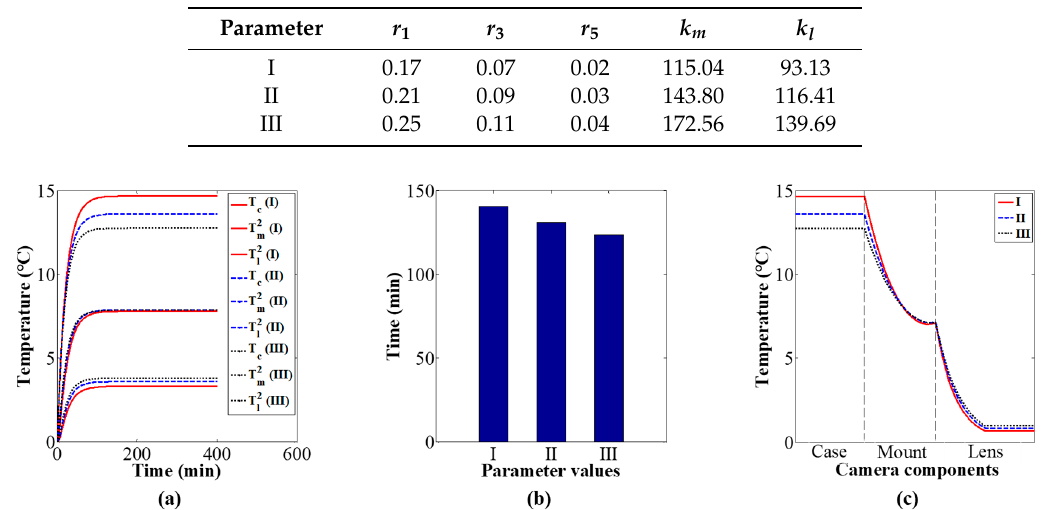
Table 4. Values of heat conduction parameters.